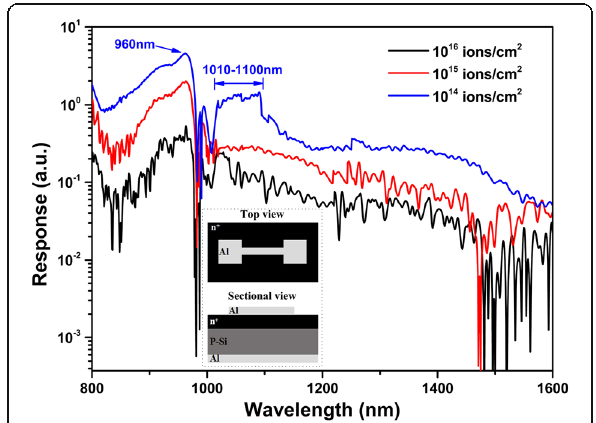
Fig. 3 Photoresponse of n+/p detectors with different ion-implantation dose. Inset shows the top view and sectional view of the device. Light gray shows the patterns of interdigitated contact on microstructured surface and all standing contact on